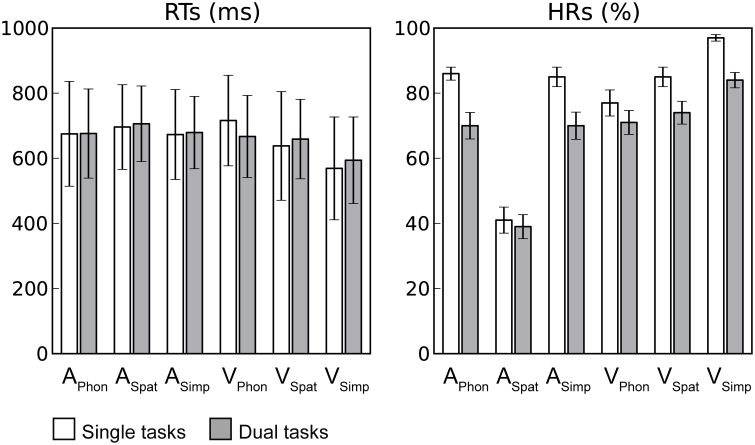
Task performance. Mean reaction times (RTs; includes only hit responses) and hit rates (HRs) during single (white columns) and dual (gray columns) task conditions for each auditory and visual component task. Error bars indicate SEMs (APhon, ASpat, and ASimp = Auditory phonological, spatial and simple component tasks, respectively and VPhon, VSpat, and VSimp = Visual phonological, spatial and simple component tasks, respectively).